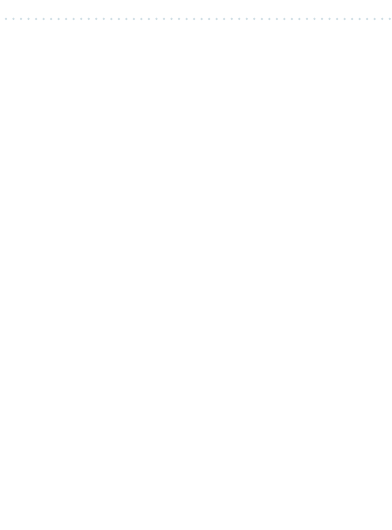
Figure 6. ( a ) Standard and modified Proctor compaction curves compared to ( b ) the dry density distribution of the mud dauber nest samples ( modified from Fig. 3c).